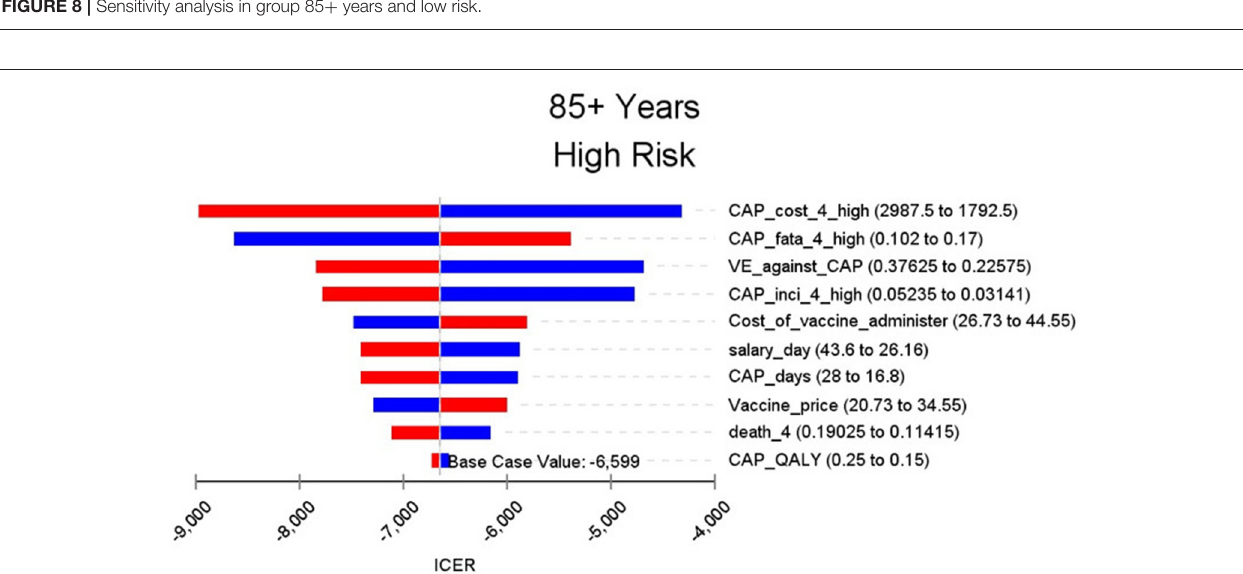
FIGURE 9 | Sensitivity analysis in group 85 + years and high